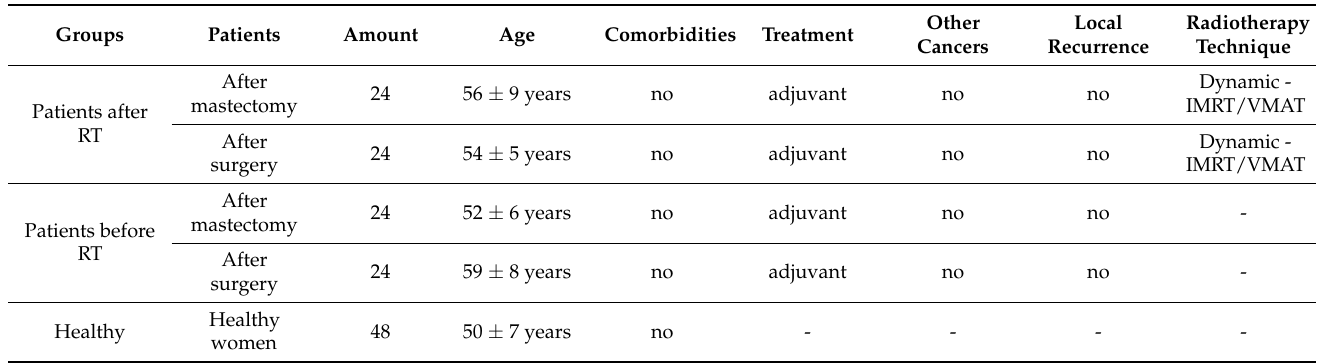
Table 1. Summary of patient eligibility information for the research.